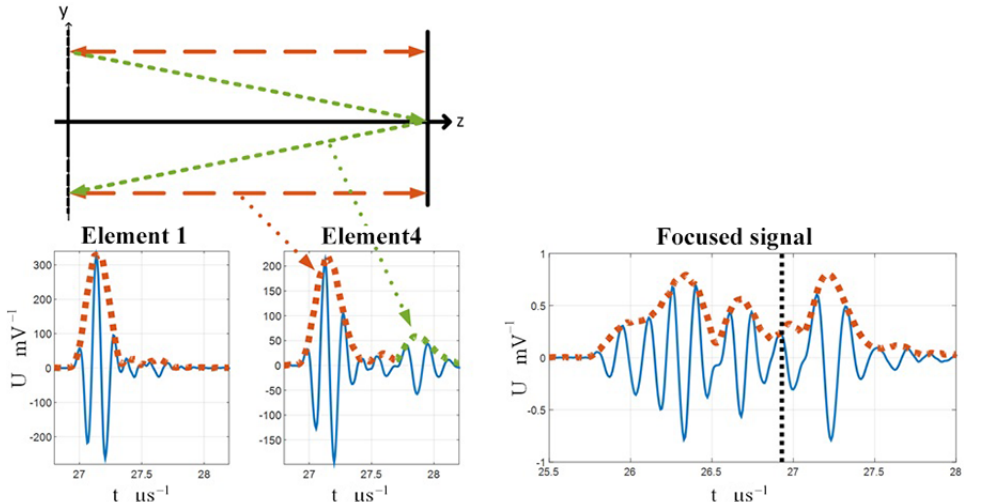
Figure 7. Signals for different propagation paths.